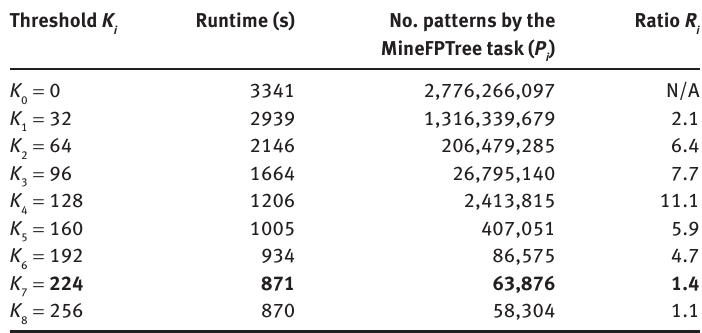
Table 3. Measurements of FEM for Kosarak (Minsup = 0.07%). Threshold K i